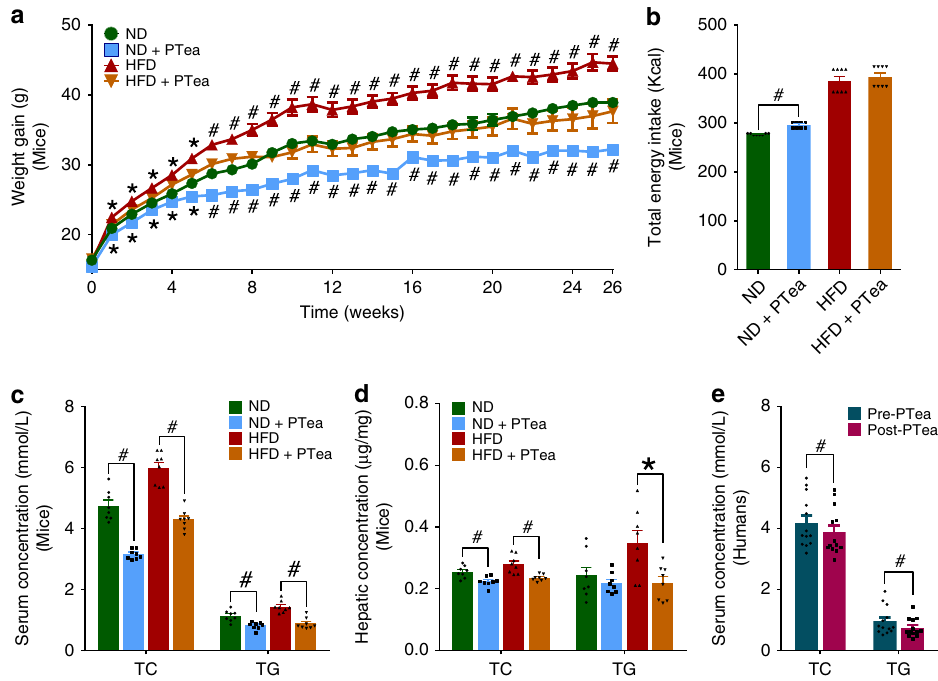
Fig. 1 Body weight and lipid lowering effects of Pu-erh tea. a Pu-erh tea reduced the body weight of mice with either normal diet or HFD for 26 weeks. n = 8 individuals/group. Data in ND and HFD groups were compared to ND + PTea and HFD + PTea groups, respectively. b The total energy intake of normal diet or HFD fed mice after 26 weeks of tea intervention. n = 8 individuals/group. c Pu-erh tea reduced serum lipids of mice with either normal diet or HFD for 26 weeks. n = 8 individuals/group. d Pu-erh tea reduced hepatic TG and TC contents of mice with either normal diet or HFD. n = 8 individuals/group. e Pu-erh tea reduced serum lipids of human subjects after 4 weeks of consumption. n = 13 individuals/group. Data were expressed as mean ± SEM. Differences of data in mice and human subjects were assessed by the Mann – Whitney U test and Wilcoxon rank-sum test, respectively, * p < 0.05, # p <